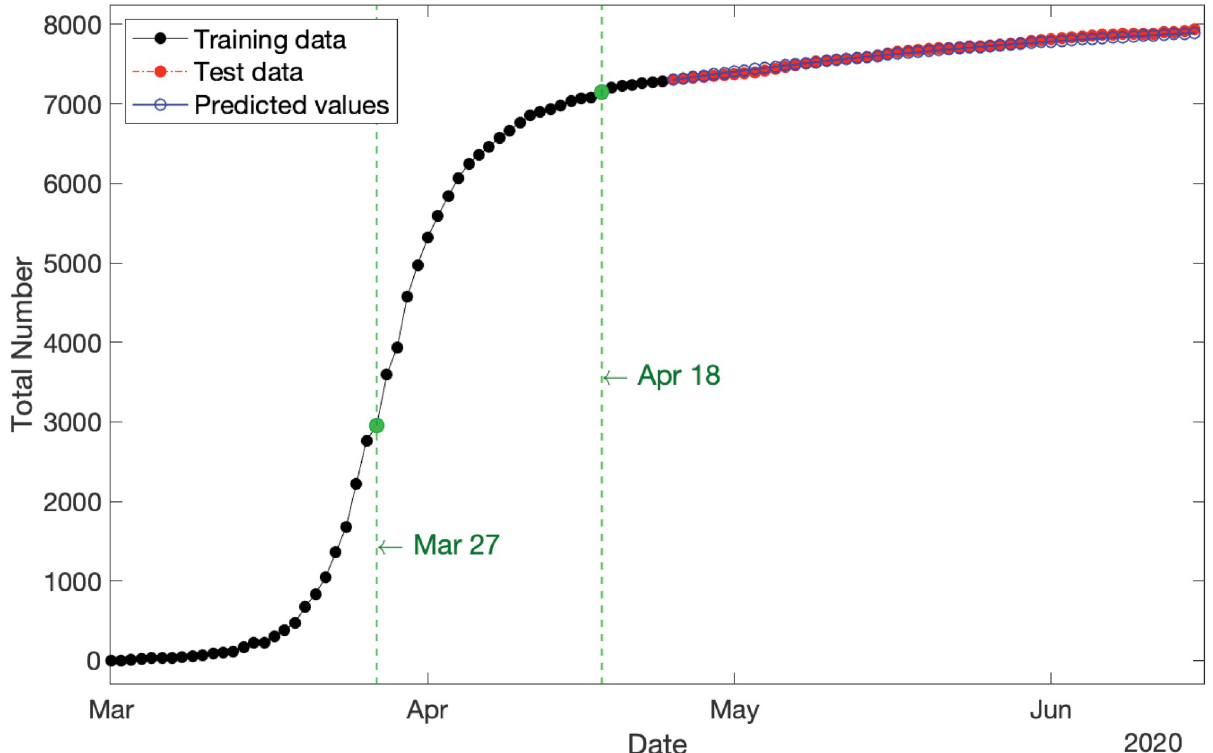
Fig 7. Cumulative new COVID-19 cases in Australia for three categories: (i) training data spanning 1 March–24 April 2020 (in black), test data spanning 25 April–15 June 2020 (in red), and (iii) predicted values over the period of test data (in blue) with MAPE = 0.26%. The two break points are marked in